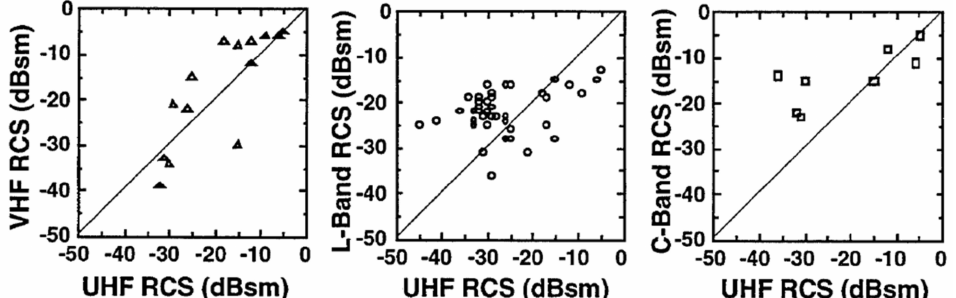
Figure 3. Results from joint debris tracks for the smallest debris, comparing VHF (ALTAIR), L-band (TRADEX), and C-band (ALCOR) radar cross section (RCS) vs. UHF (ALTAIR) RCS [14]. Reprinted with permission courtesy of MIT Lincoln Laboratory, Lexington, Massachusetts.